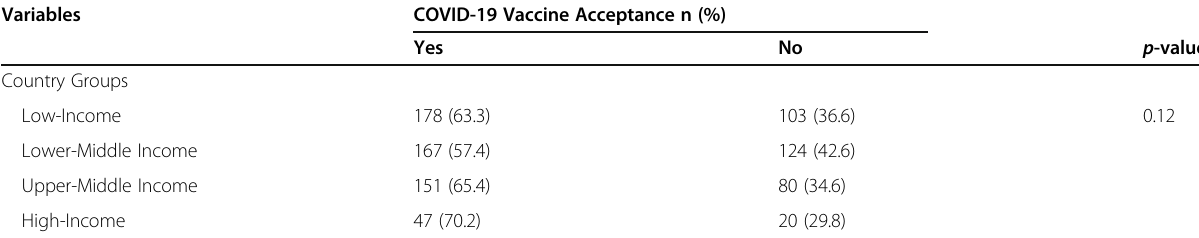
Table 3 Bivariate Associations Between Respondents Characteristics and COVID-19 Vaccine Acceptance ( N = 870)